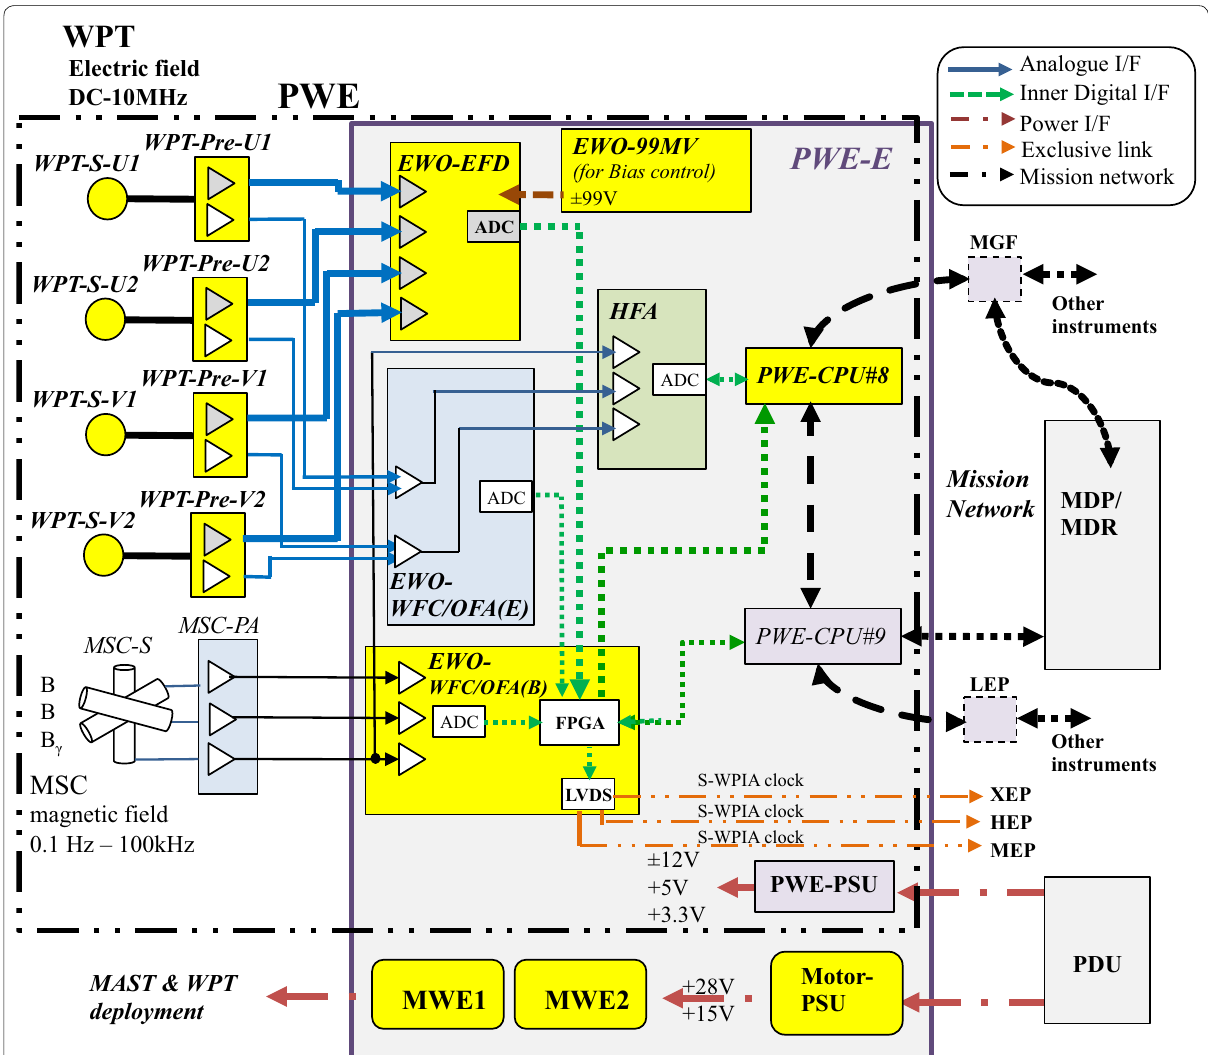
Fig. 1 Block diagram of the PWE and related systems aboard the Arase spacecraft. This paper deals with the WPT and EFD systems (yellow parts) in the PWE. [Modified from Fig. 2 of Kasahara et al. (2017)]